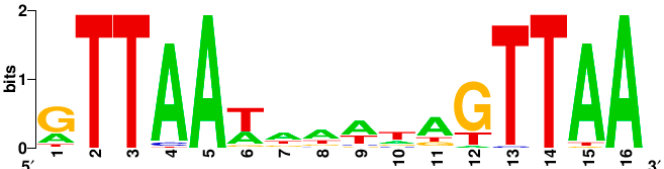
Figure 3. The consensus sequence of the SaeR binding sequence. It was generated by WebLogo (http://weblogo.berkeley.edu/logo.cgi) using the SaeR binding sequences in Table 1.